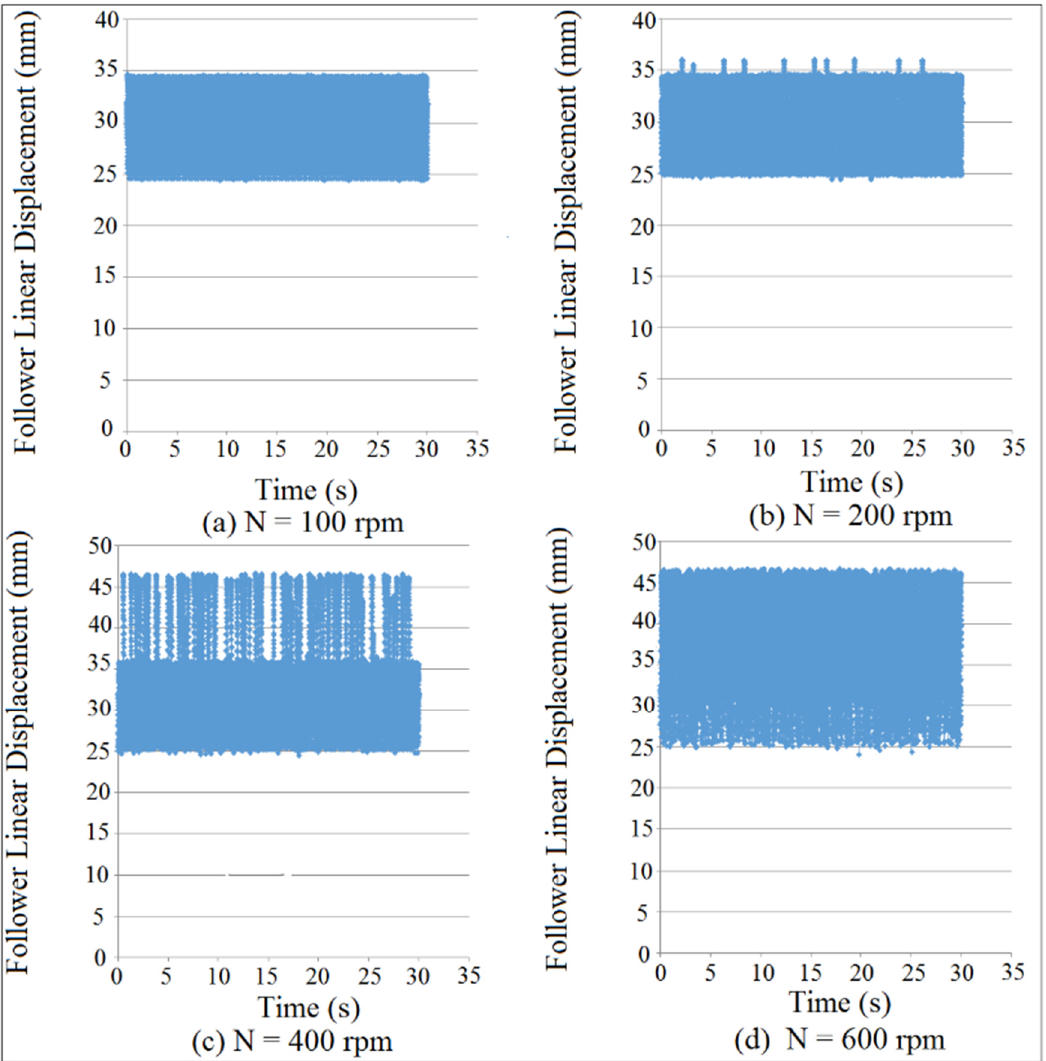
Figure 8. Follower linear displacement mapping against time for (I.D. = 16 mm).